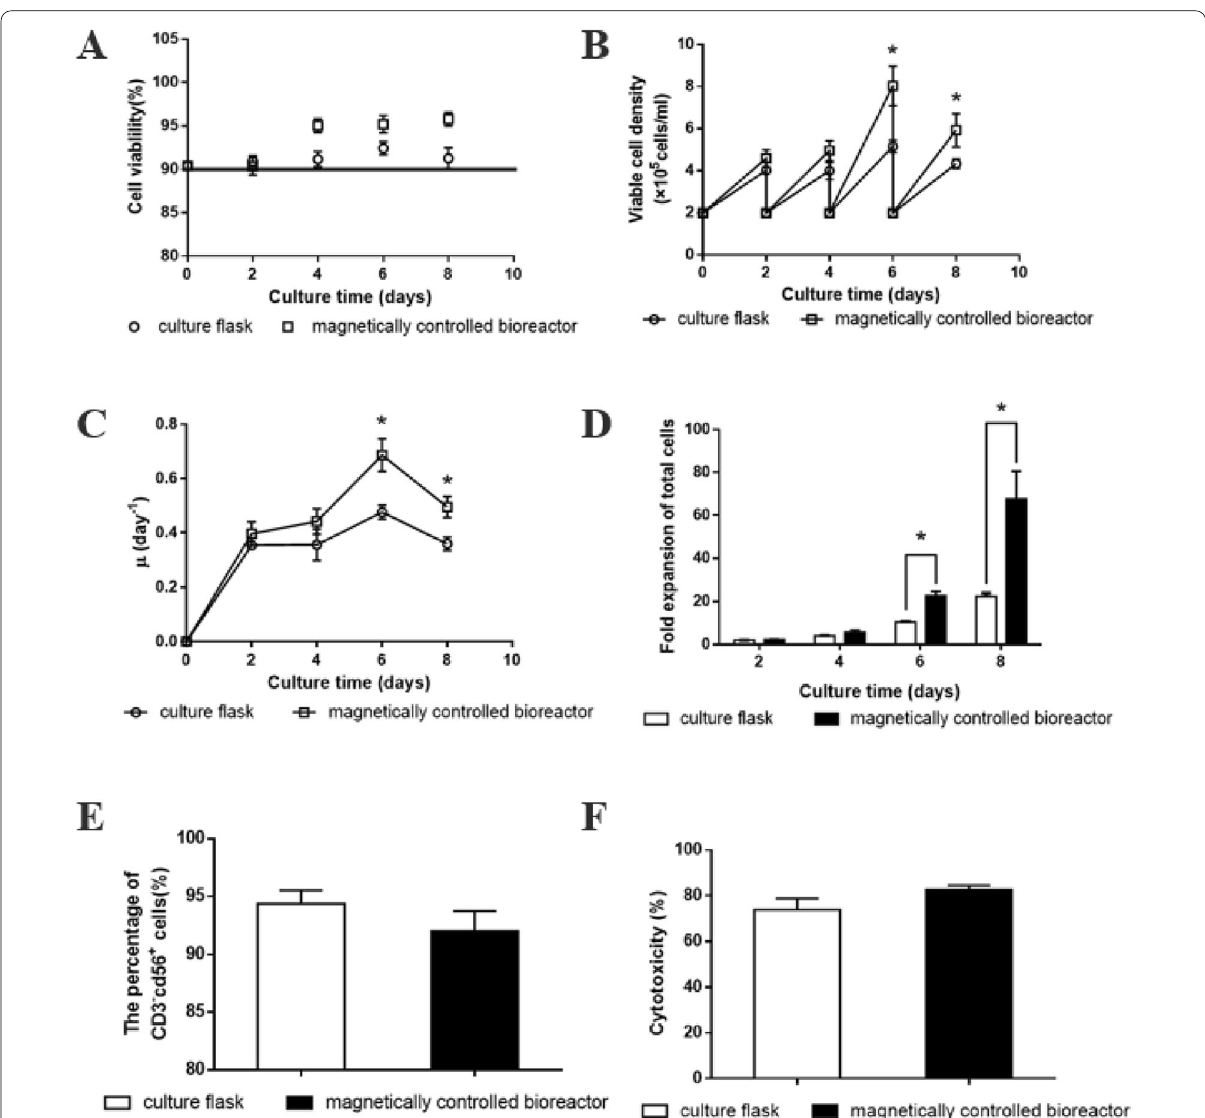
Fig. 7 Time profiles of ex vivo expansion and physiological function of NK92 cells in culture flask and the magnetically controlled bioreactor within 8 days (*compared with static cultures, P < 0.05). A Cell viability. B Viable cell density. C Specific growth rate of total cells. D Expansion folds of total cells. E The percentage of CD3 − CD56 + cells of ex vivo‑expanded CIK cells. F Cytotoxic capacity of ex vivo‑expanded CIK